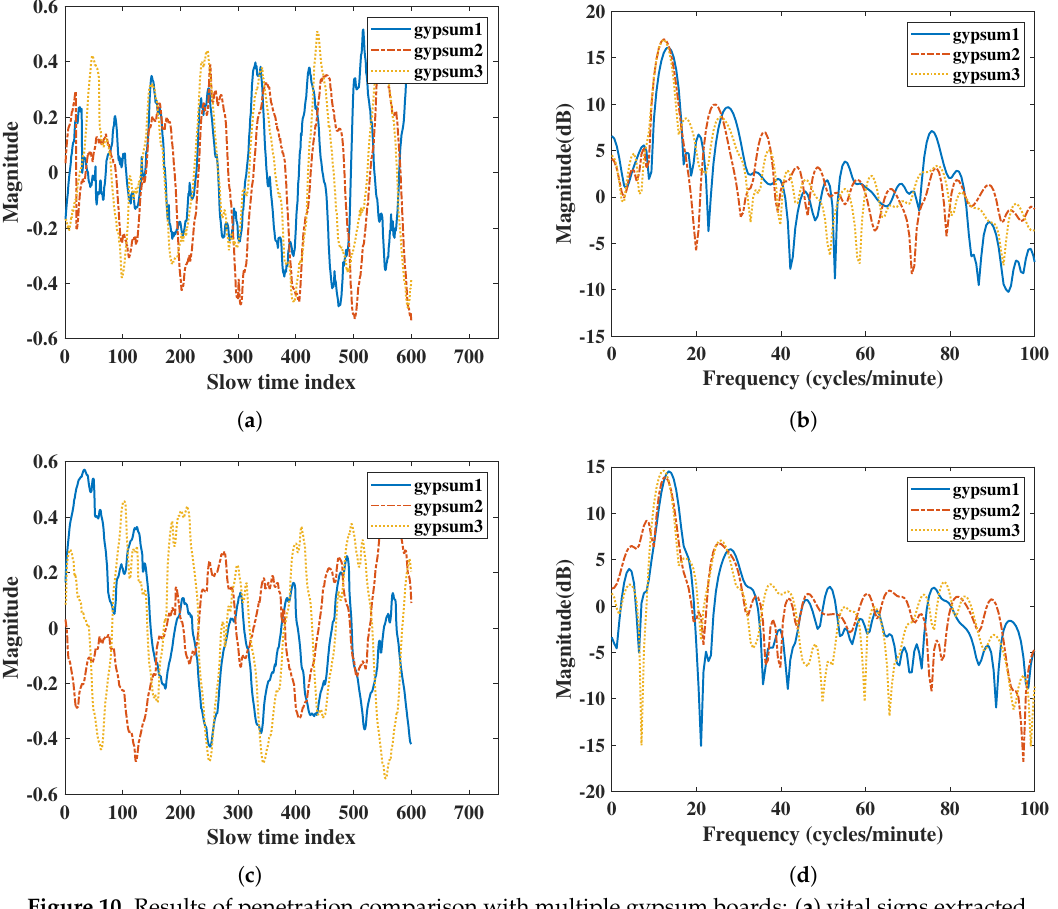
Figure 10. Results of penetration comparison with multiple gypsum boards: ( a ) vital signs extracted by IR-UWB radar in time domain, ( b ) vital signs extracted by IR-UWB radar in the frequency domain, ( c ) vital signs extracted by FMCW radar in the time domain, ( d ) vital signs extracted by FMCW radar in the frequency domain.